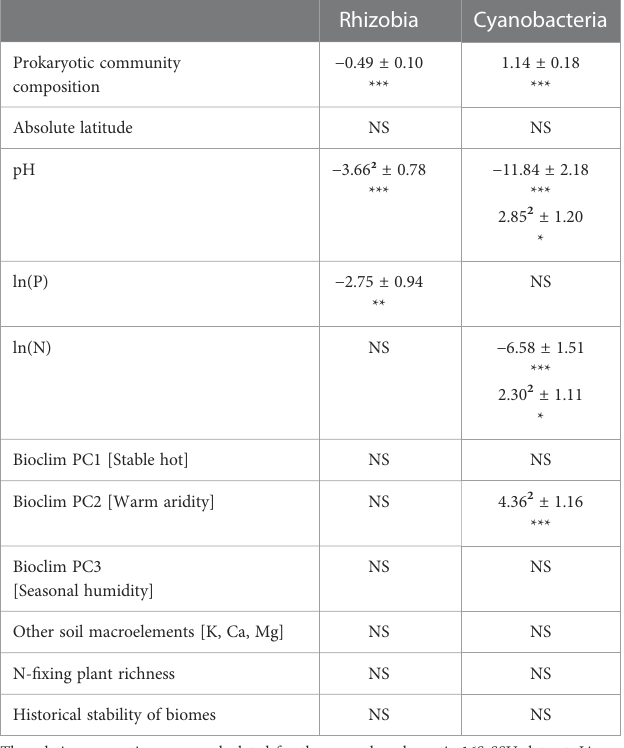
The relative proportions were calculated for the general prokaryotic 16S SSU dataset. Linear model (using Generalised Least Squares) parameter estimates with corresponding standard errors are shown, ² following the effect size denotes the effect of the quadratic term. P values are reported as follows: NS, not signi fi cant; *p < 0.05; **p < 0.01; ***p <